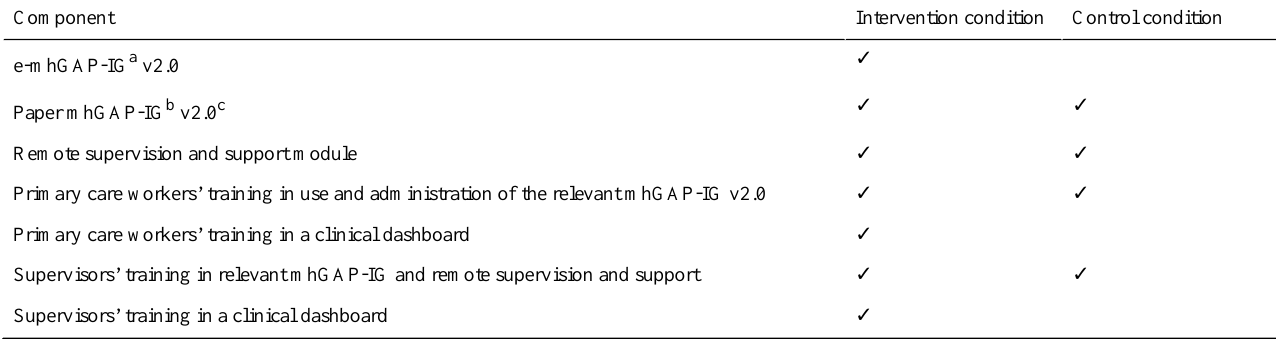
Table 1. Feasibility study arm